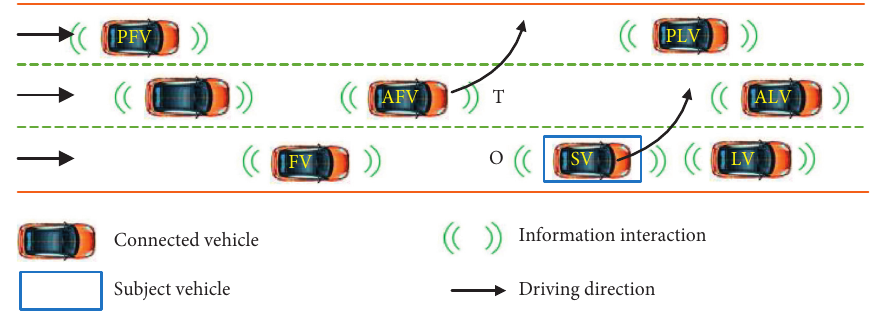
Figure 2: Collaborative lane change